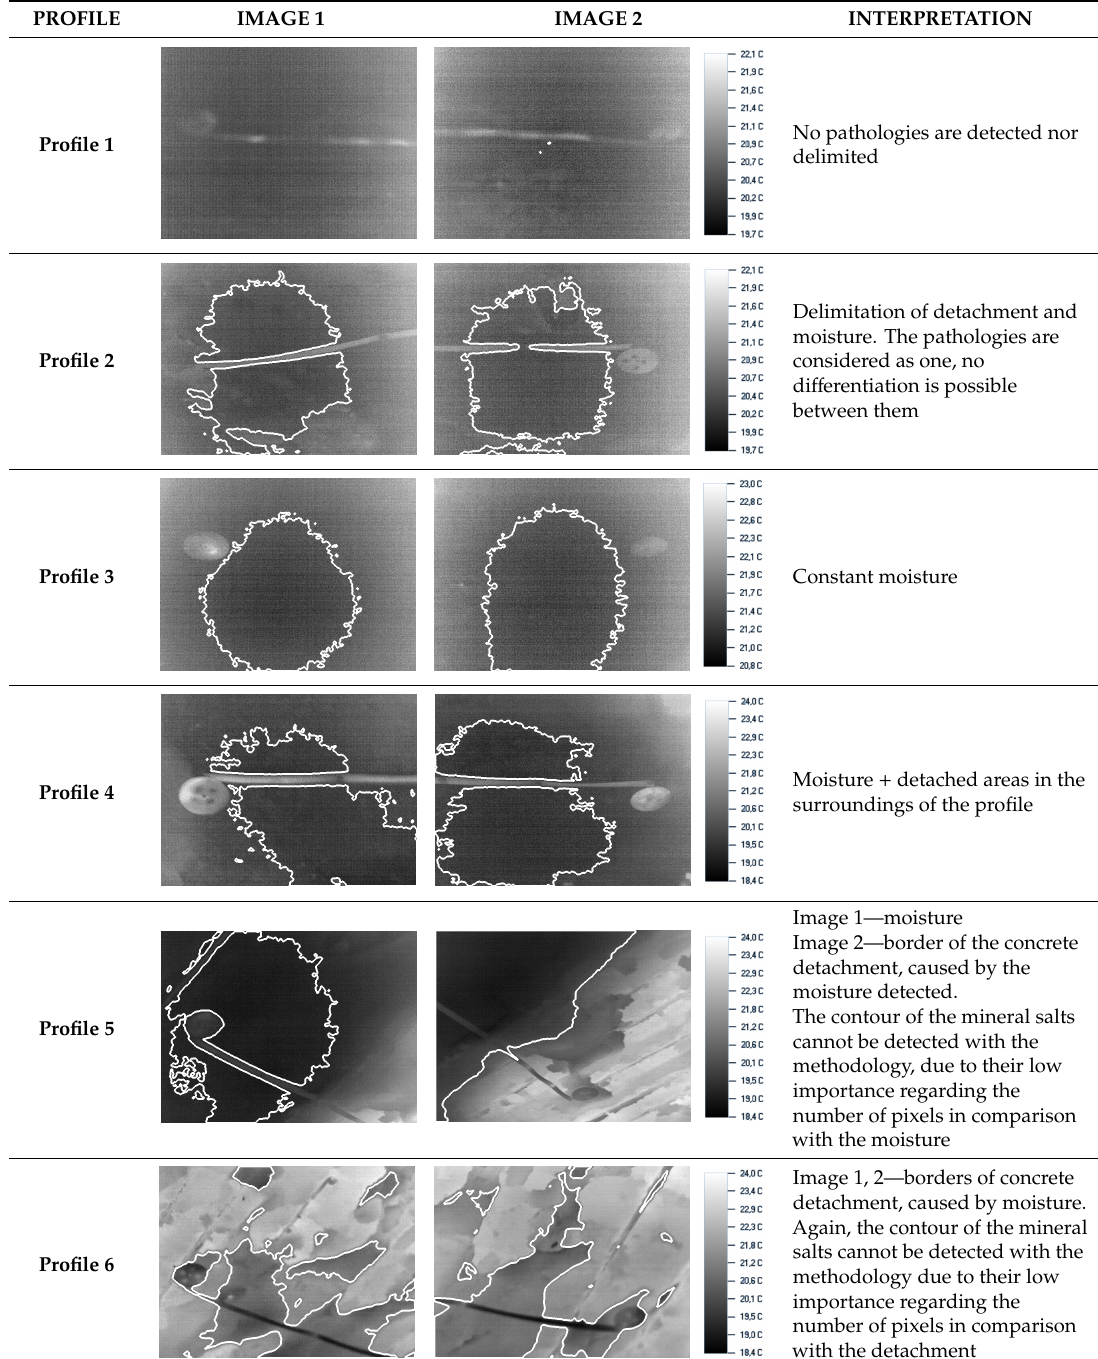
Image 1—moisture Image 2—border of the concrete detachment, caused by the moisture